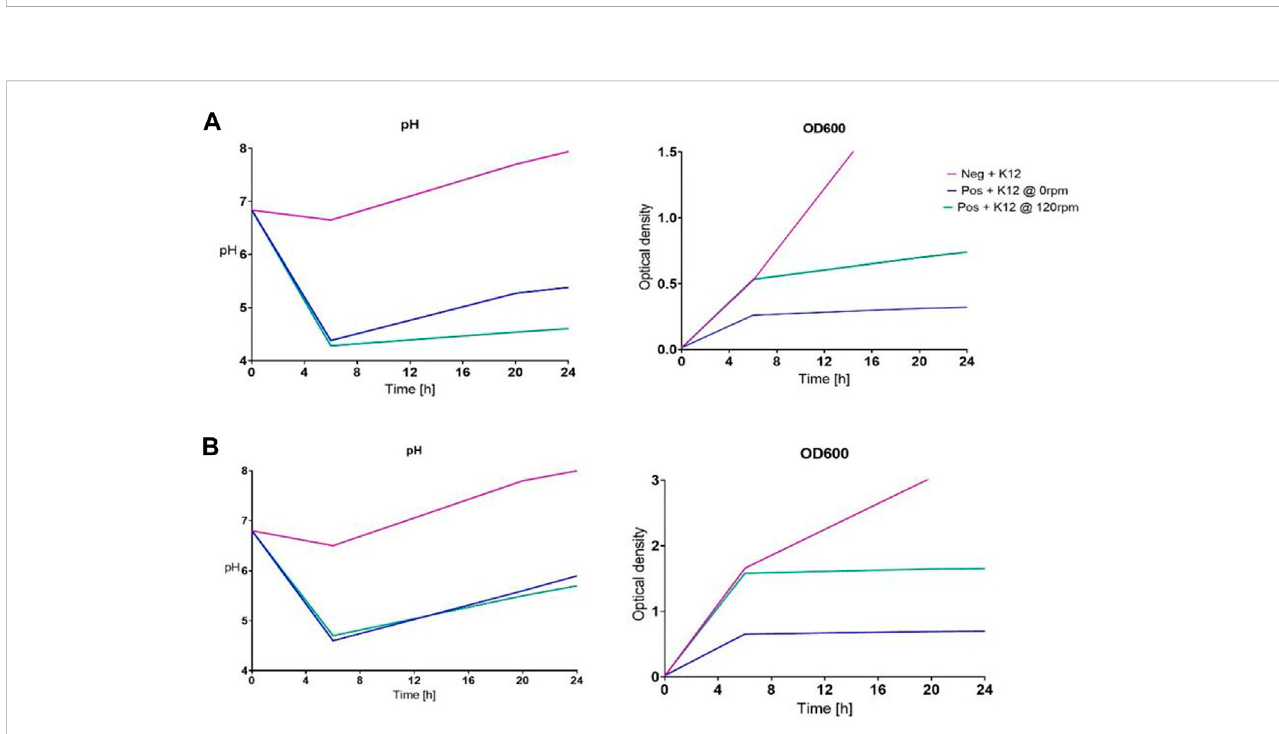
FIGURE 6 Depiction of pH and OD 600 propagation over the course of the two experimental runs, comparing streak plate-originated o/n cultures against cryo- originated organisms: (A) taken from the streak plate and (B) taken from the cryo cell